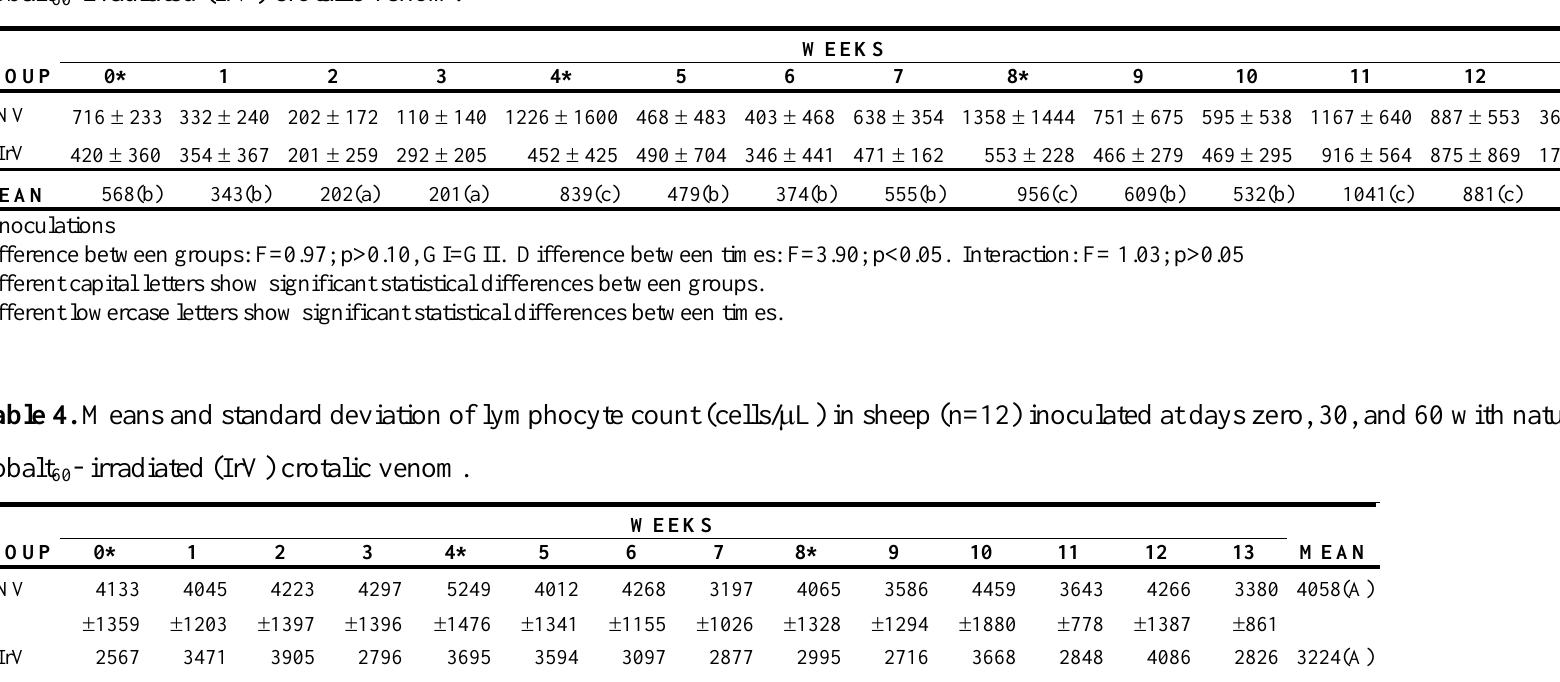
Table 3. Means and standard deviation of eosinophil count (cells/ µ L) in sheep (n=12) inoculated at days zero, 30, and 60 with natural (NV) and -irradiated (IrV) crotalic venom. Cobalt 60